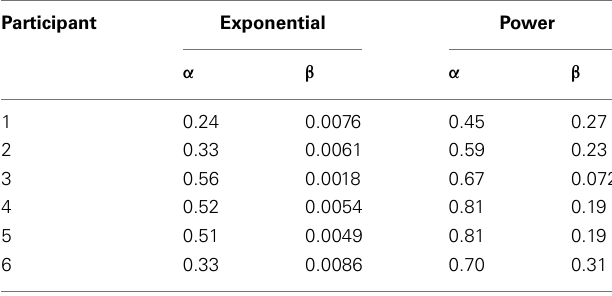
Table 6 | Best fitting parameter values for the two-parameter power and exponential